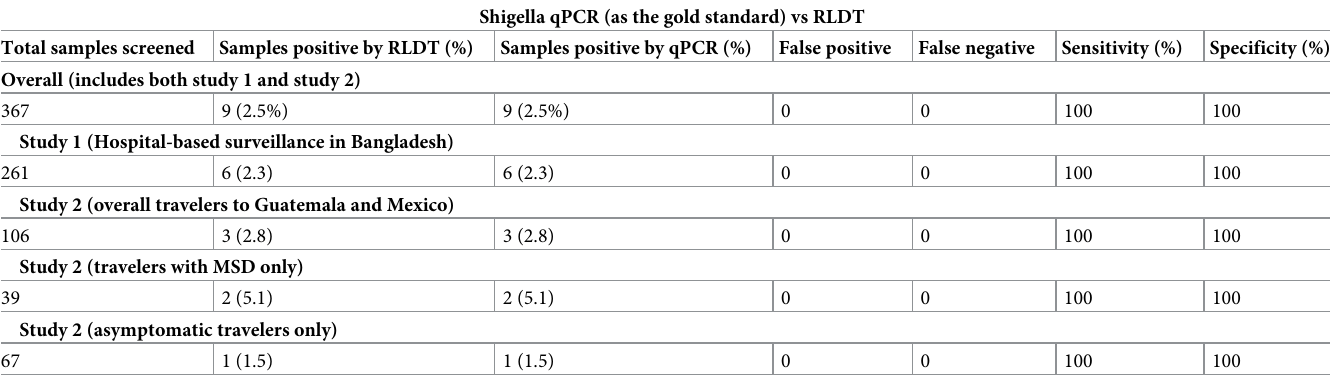
Table 2. Sensitivity and specificity of Shigella RLDT compared to qPCR. Shigella qPCR (as the gold standard) vs